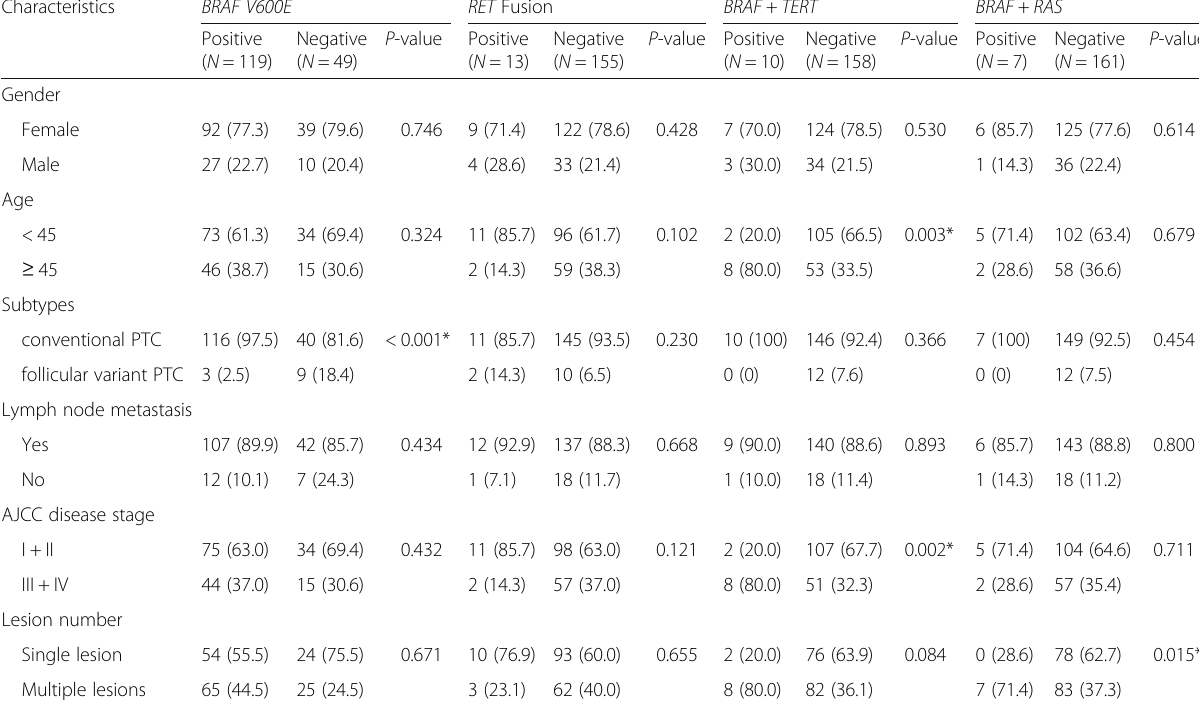
Table 4 Relationships between BRAF V600E alone or RET fusion alone or BRAF + TERT or BRAF + RAS mutations and clinicopathological features in PTC patients